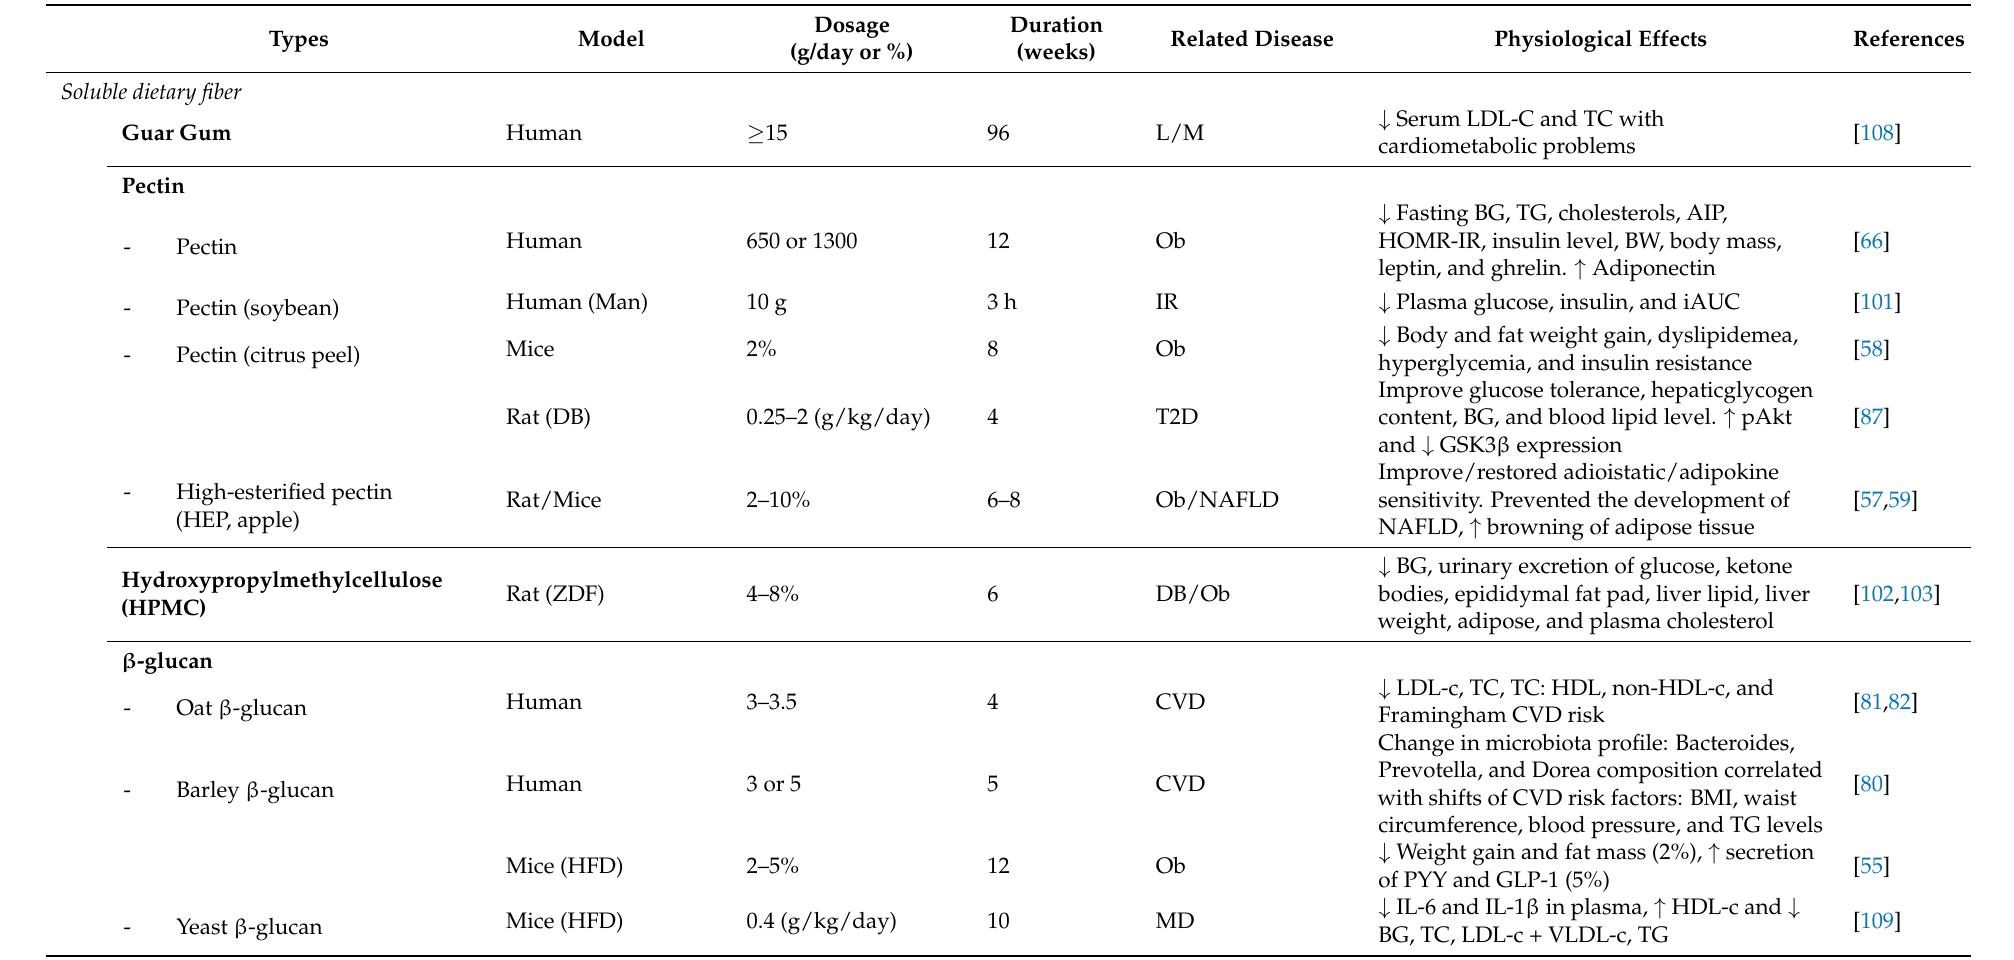
Table 2. The effect of NDCs on metabolic